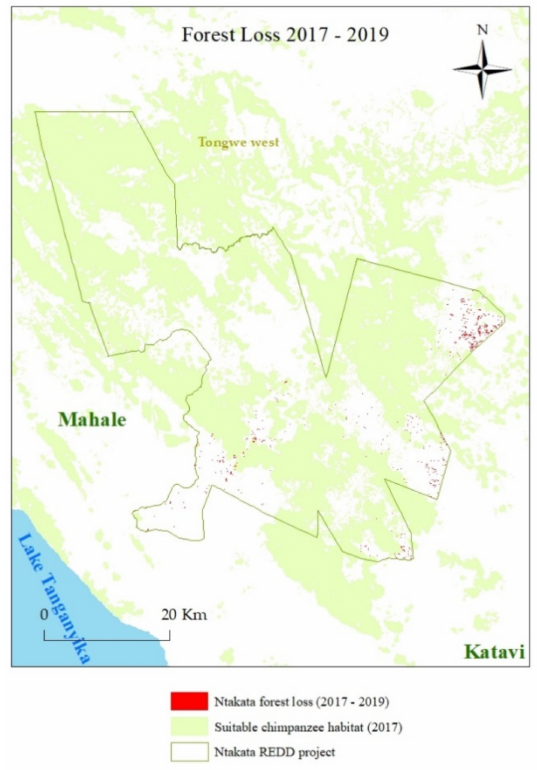
Figure 4. Forest cover loss during the period 2017–2019 in the Ntakata Moutains REDD project (NMRP). All maps are in projection WGS84 UTM Zone